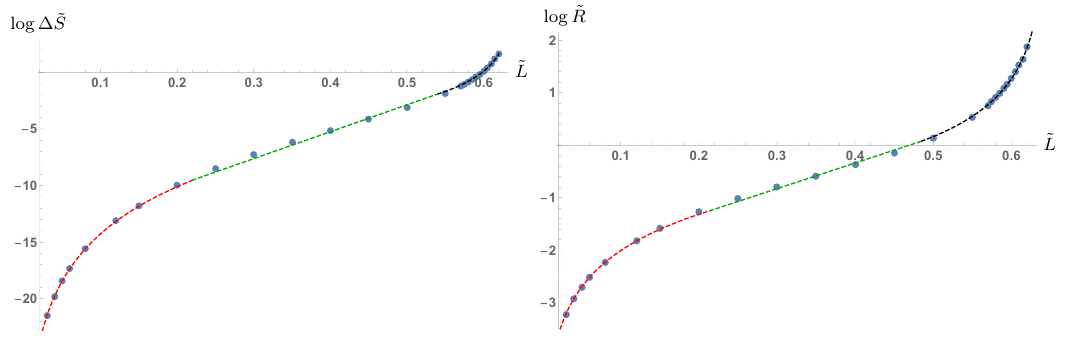
Figure 11 . The on-shell action and the radius of the O(4) -bubble as a function of ˜ L in a semilog- arithmic scale. The dots represent numerically computed data and the dashed lines correspond to the analytic approximation given in eqs. (5.35) and (5.36). Different colors correspond to different expressions of the piecewise